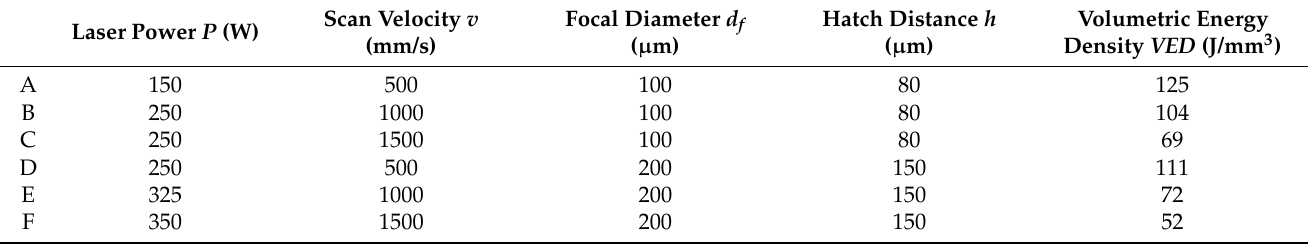
Table 2. Applied process parameters for the LPBF experiments. For all experiments, no base plate heating was used, and the layer thickness was kept constant at 30 µ